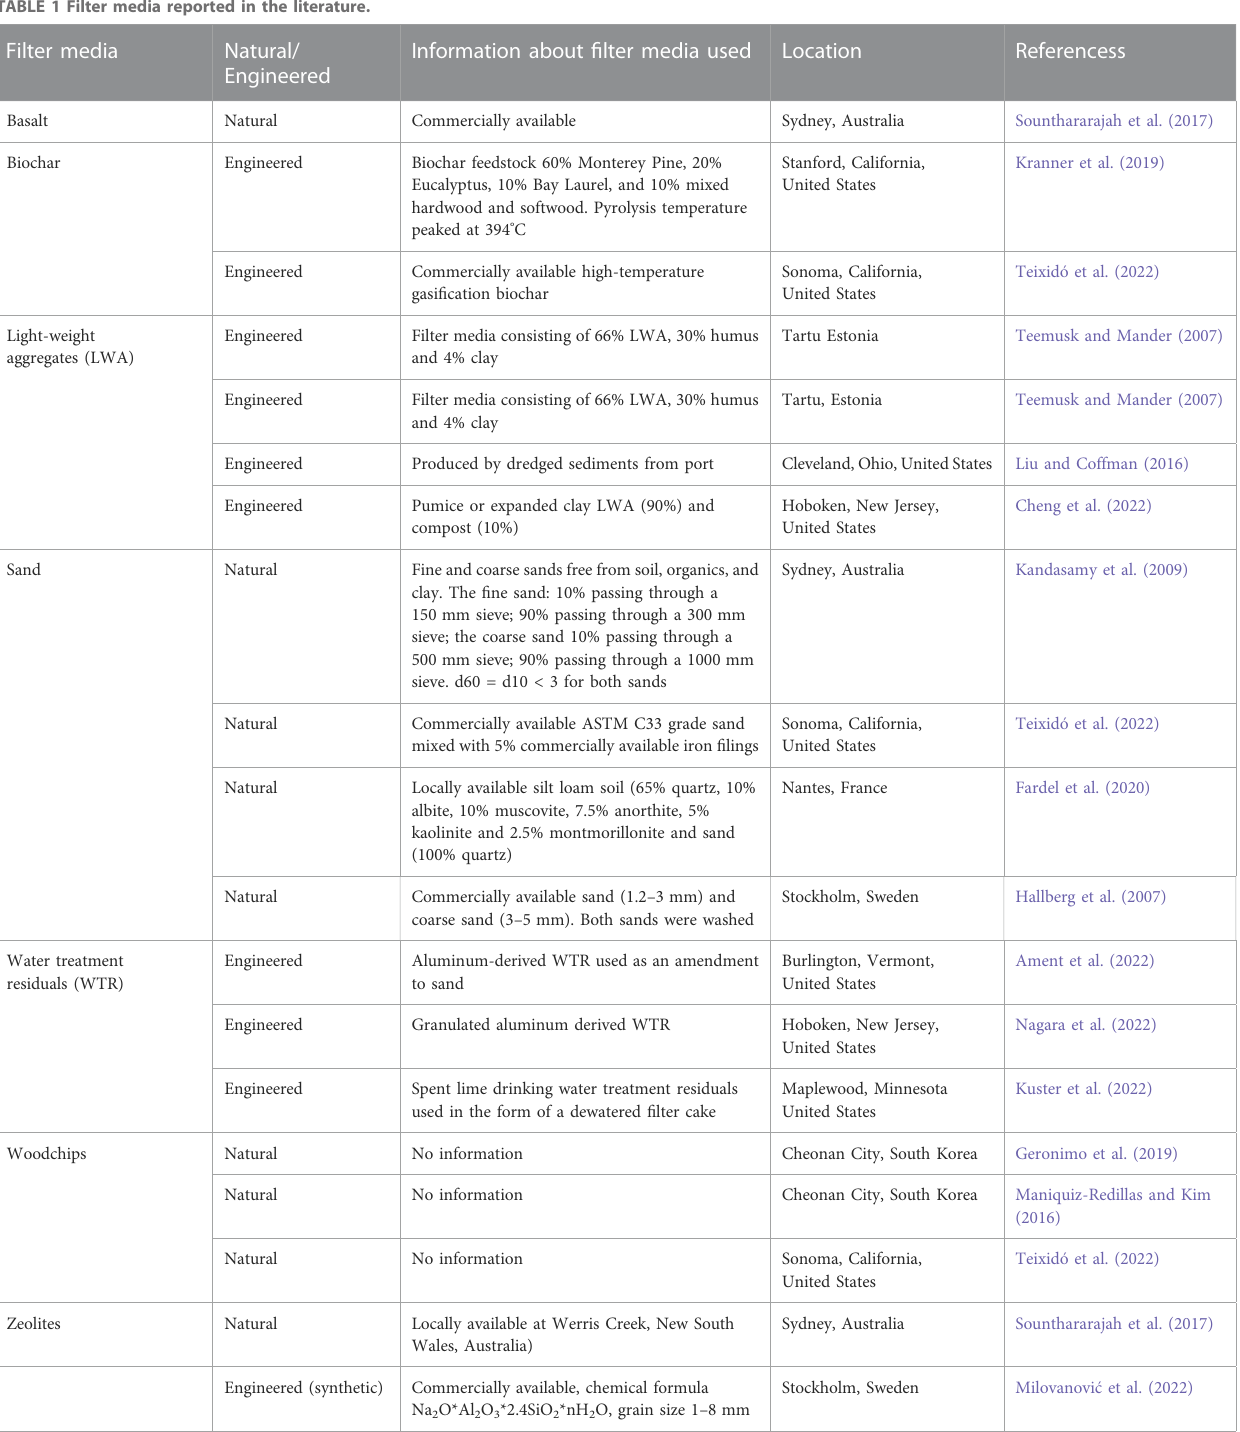
TABLE 1 Filter media reported in the